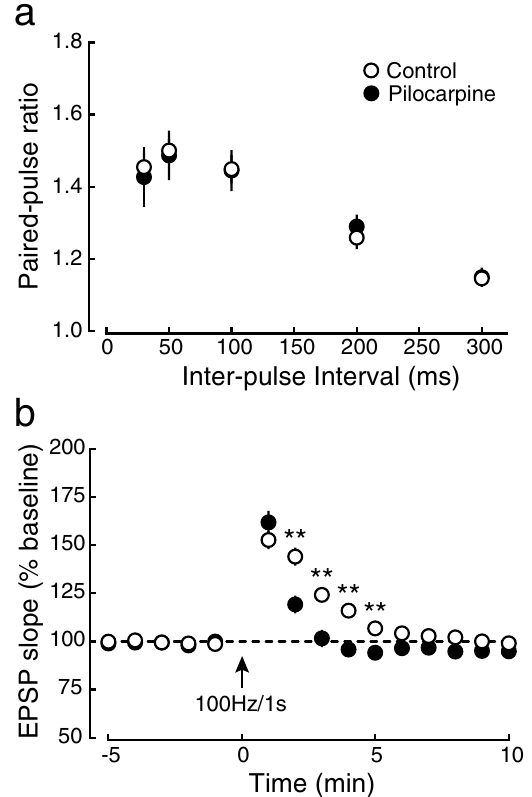
Figure 5. Epileptic seizures are not responsible for the phenotypes in short-term synaptic plasticity in KI mice. ( a ) The paired-pulse ratio was indistinguishable between saline-injected control mice (open circles: ○ , n = 8) and those exhibited an epileptic seizure by intraperitoneal administration of pilocarpine (closed circles: ● , n = 8) at all inter-pulse intervals. ( b ) PTP elicited by tetanic stimulation (100 Hz, 1 s) was indistinguishable between pilocarpine-treated (closed circles: ● , n = 8) and control mice (open circles: ○ , n = 8), although the potentiation 2 to 5 min after tetanic stimulation was significantly different between the